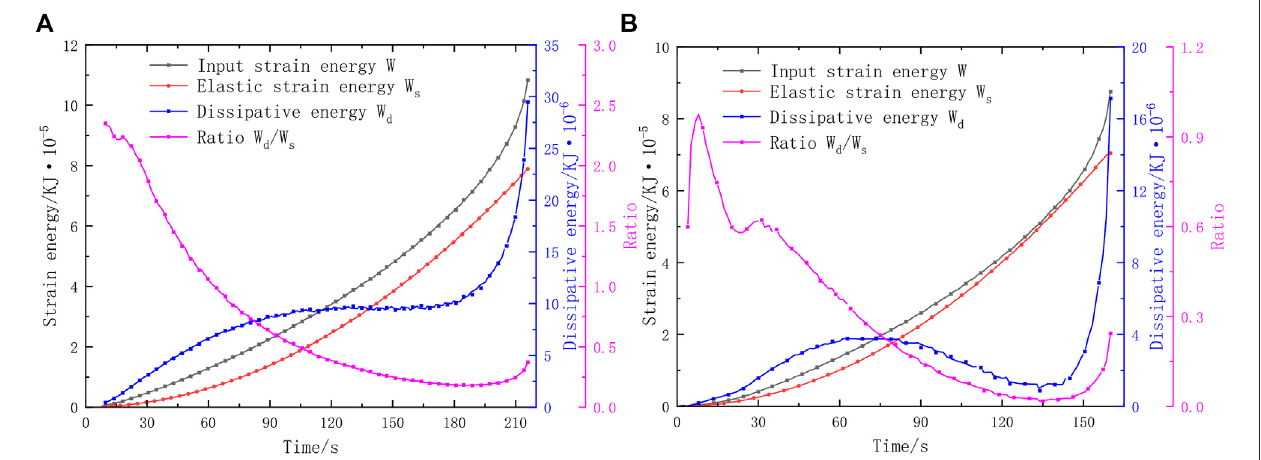
FIGURE 6 | Energy evolution in layered sandstone without an anchor: (A) No anchor 45 ° ; (B) No anchor 90 ° .